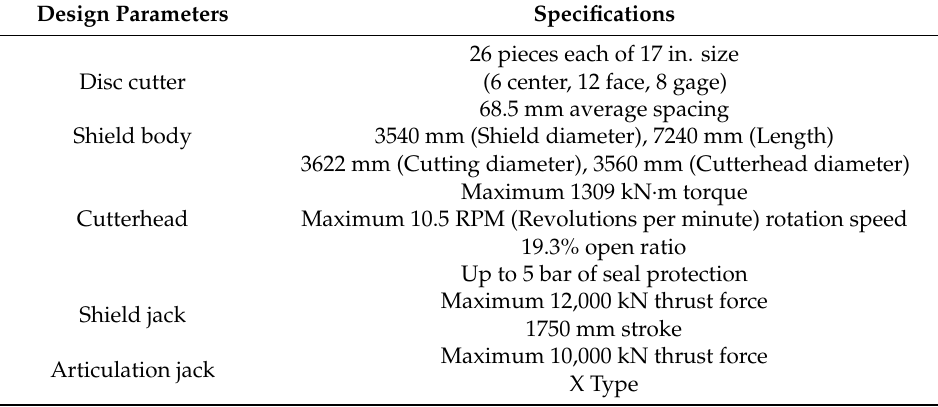
Table 1. Specifications of the developed EPB shield